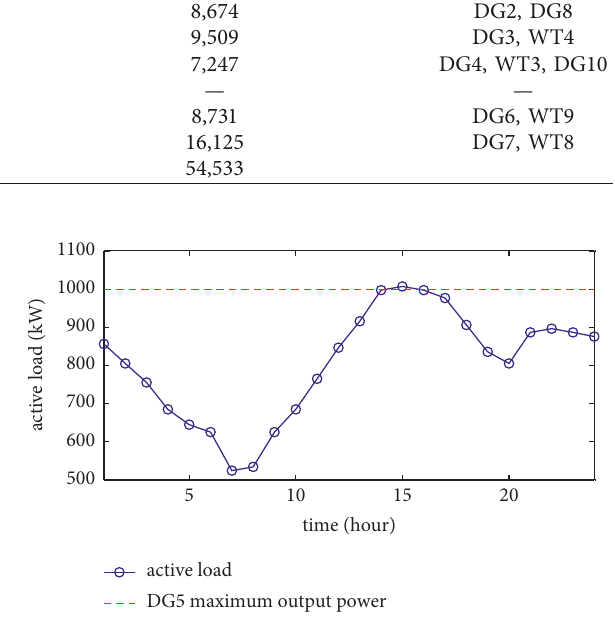
Figure 11: Active power imbalance in island with DG5 in case 1.